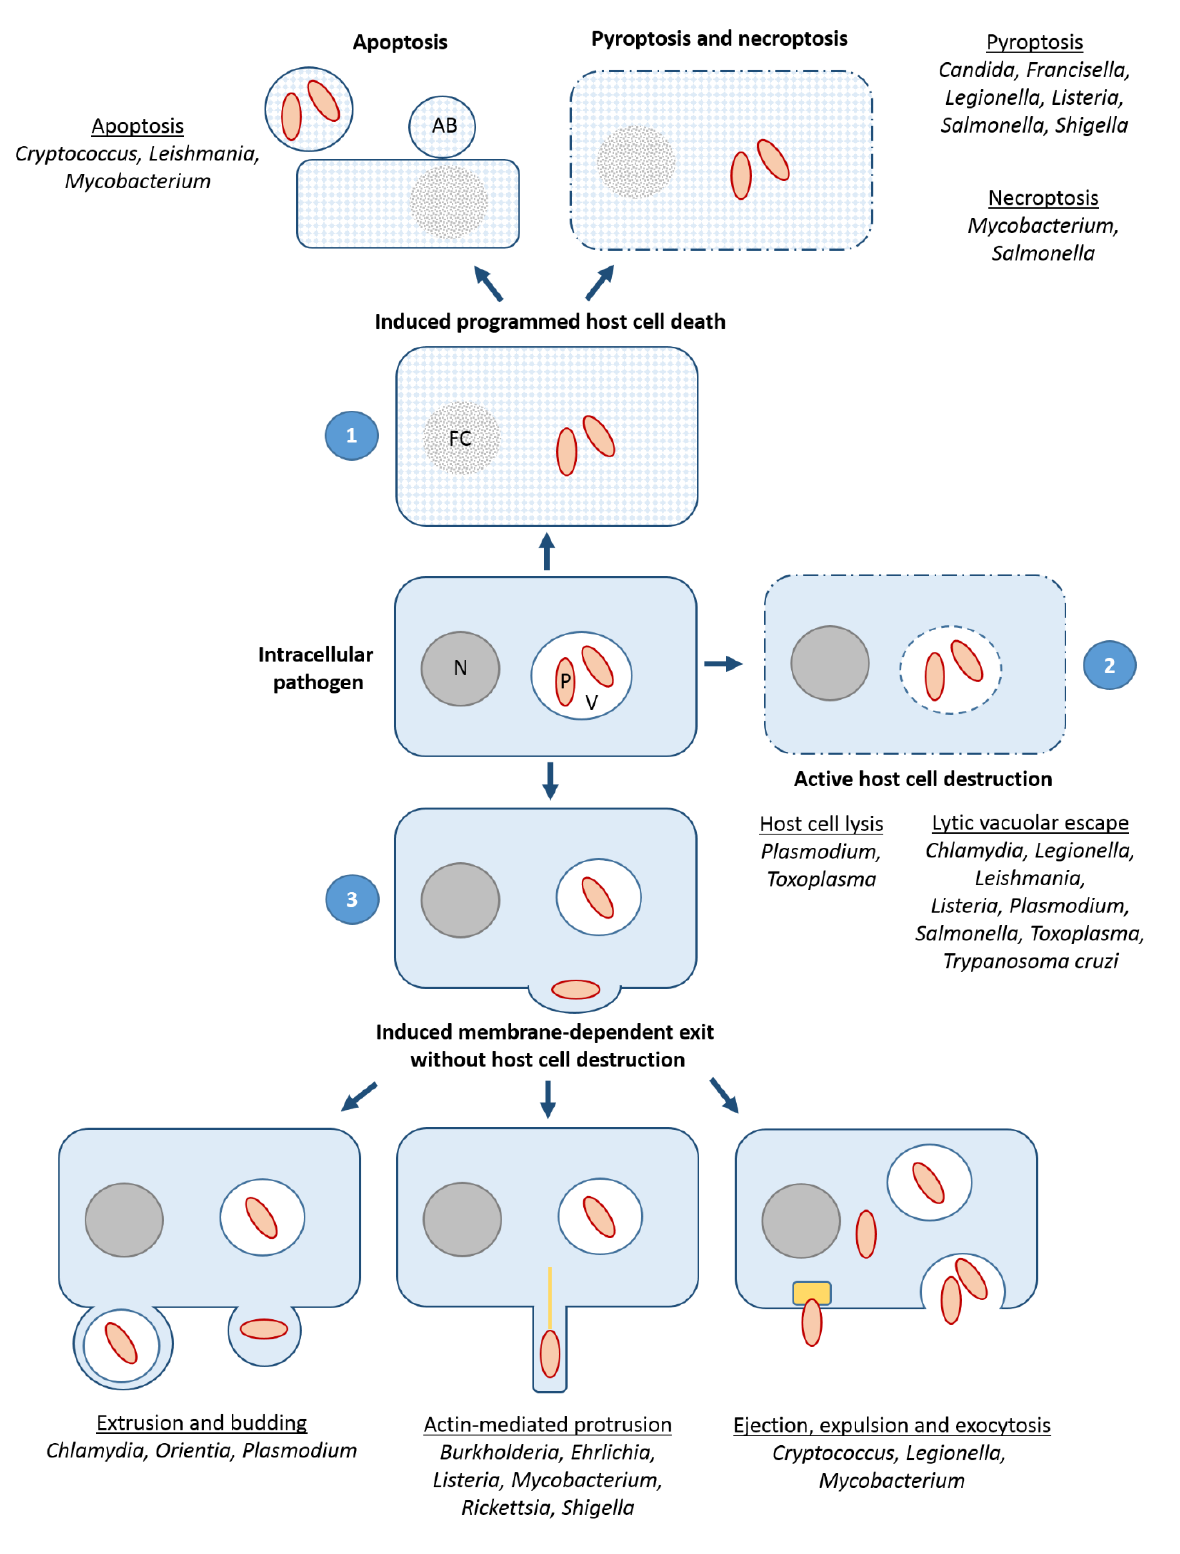
FIGURE 1: The three strategies of host cell exit. (1) Induction of programmed cell death, including the non-lytic apoptosis and the lytic necroptosis and pyroptosis pathways; (2) Active host cell destruction, comprising breaching of host cell membranes such as the vacuolar and/or the host cell plasma membrane; (3) Induced membrane-dependent exit without host cell destruction, e.g. by actin tail (yellow line)- mediated protrusions, extrusions, budding, exocytosis, expulsion or ejection via an ejectosome (yellow box). Pathogens for which distinct pathways were demonstrated are indicated. AB, apoptotic body; FC, fragmented chromatin; N, nucleus; P, pathogen; V,